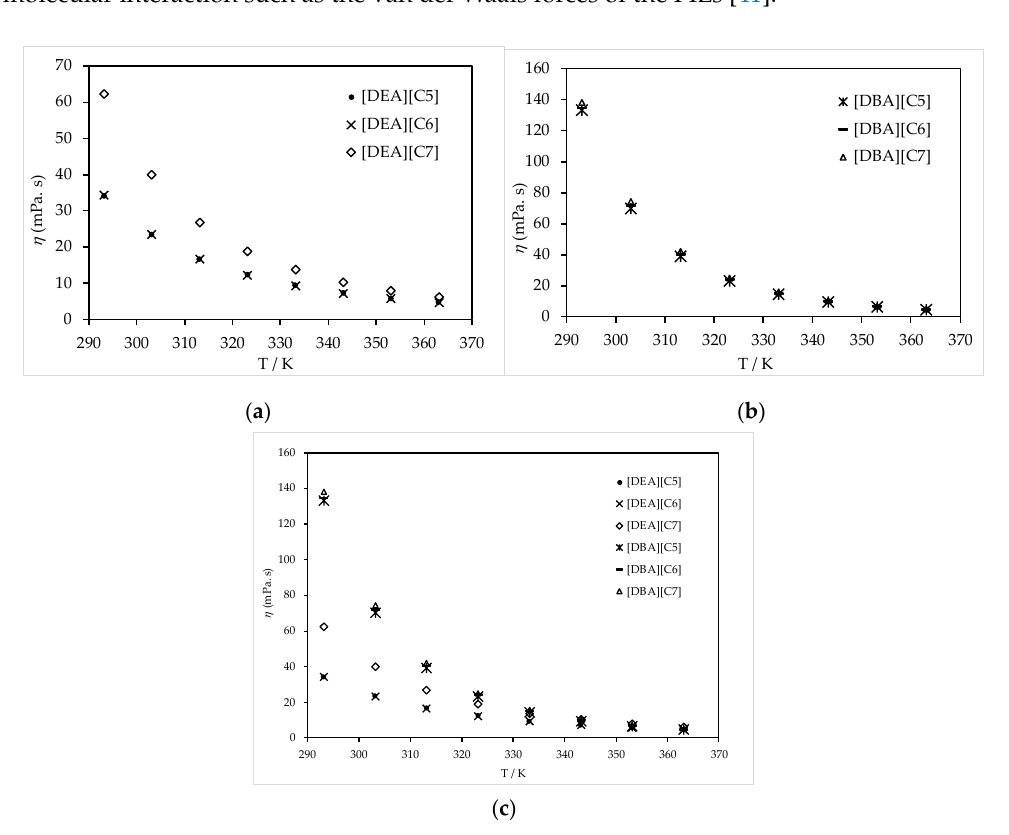
Figure 3. ( a ) Refractive index ( n D ) values of [DEA][C5], [DEA][C6] and [DEA][C7] as a function of temperature. ( b ) Refractive index ( n D ) values of [DBA][C5], [DBA][C6] and [DBA][C7] as a function of temperature.